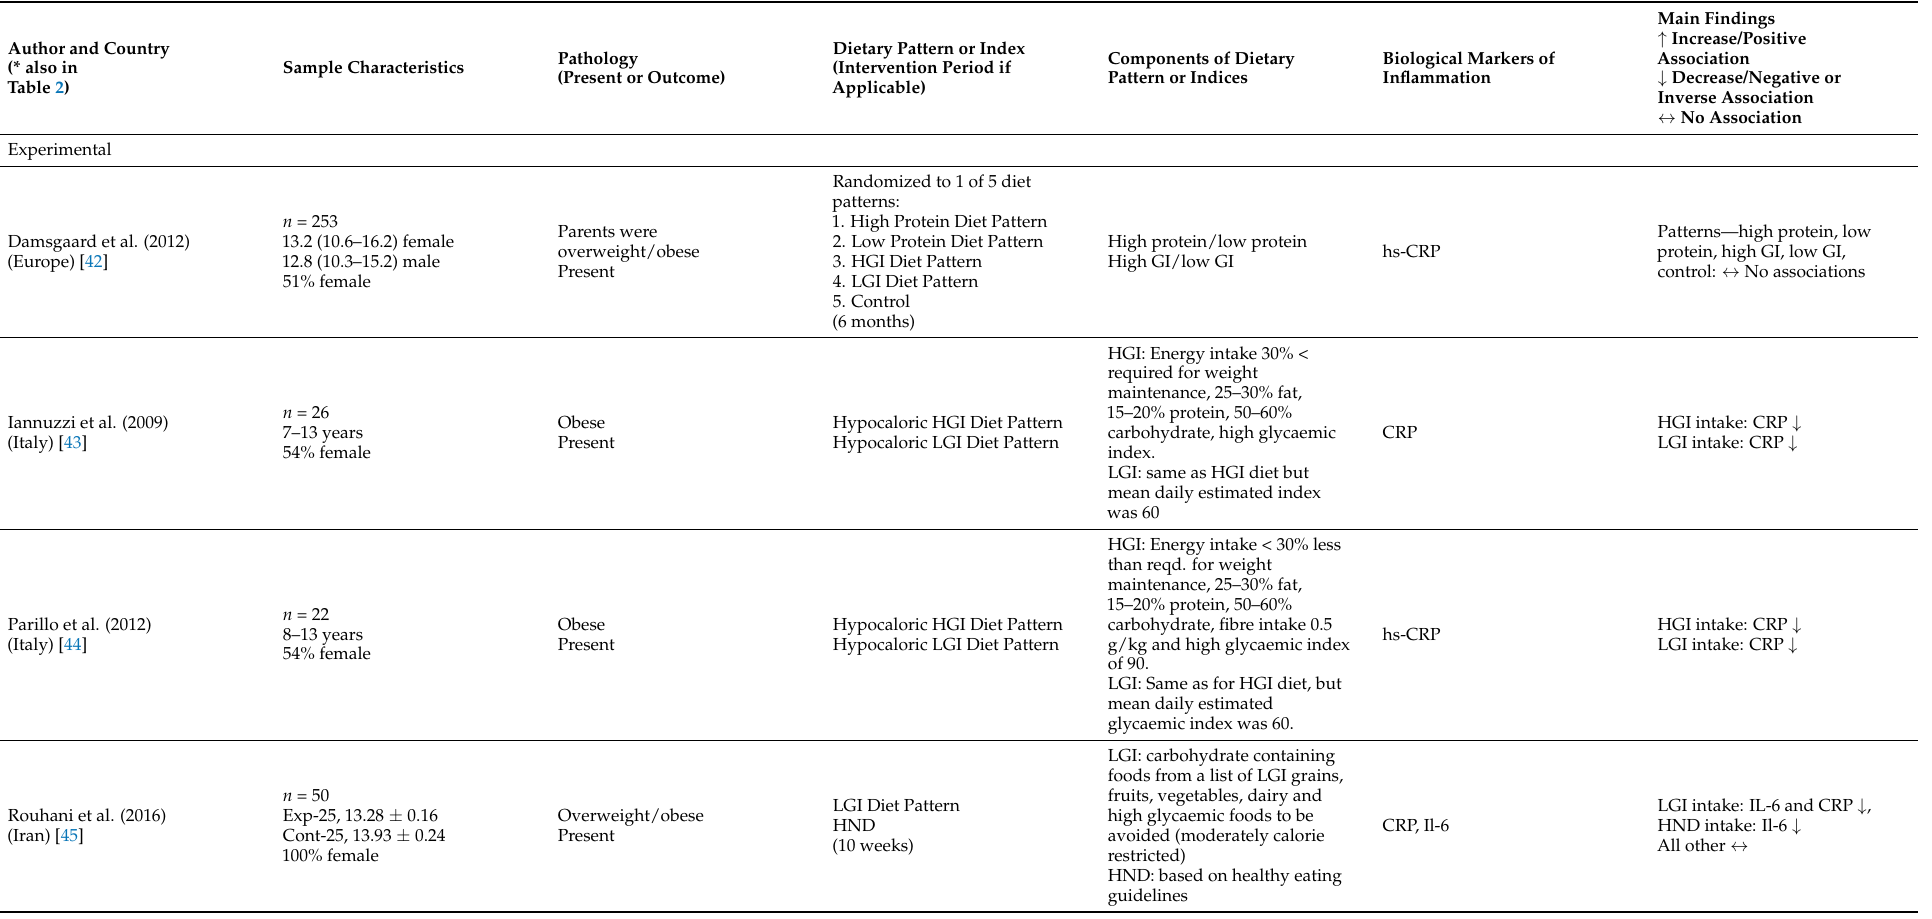
Table 1. Summary of studies investigating the associations between dietary patterns/scores/indices and biological markers of inflammation in children and adolescents.